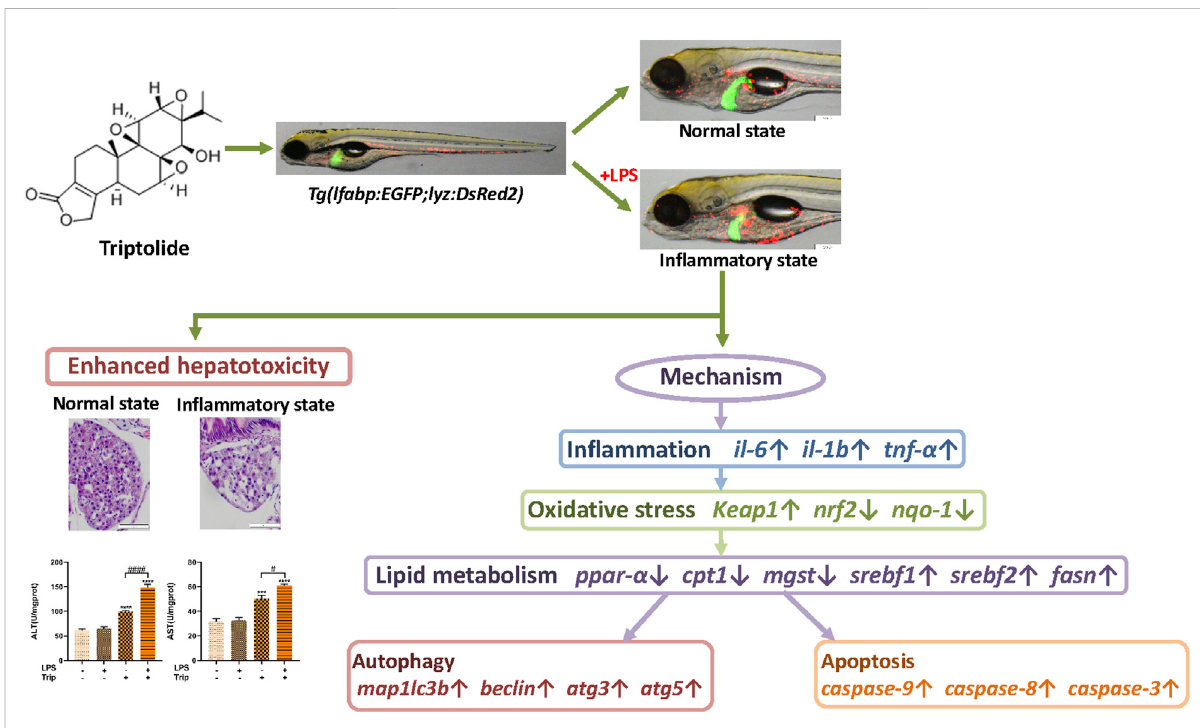
FIGURE 7 The schematic diagram of the enhanced hepatotoxicity of triptolide in zebra fi sh under in fl ammatory state regarding in fl ammation, oxidative stress, lipid metabolism, autophagy and apoptosis.